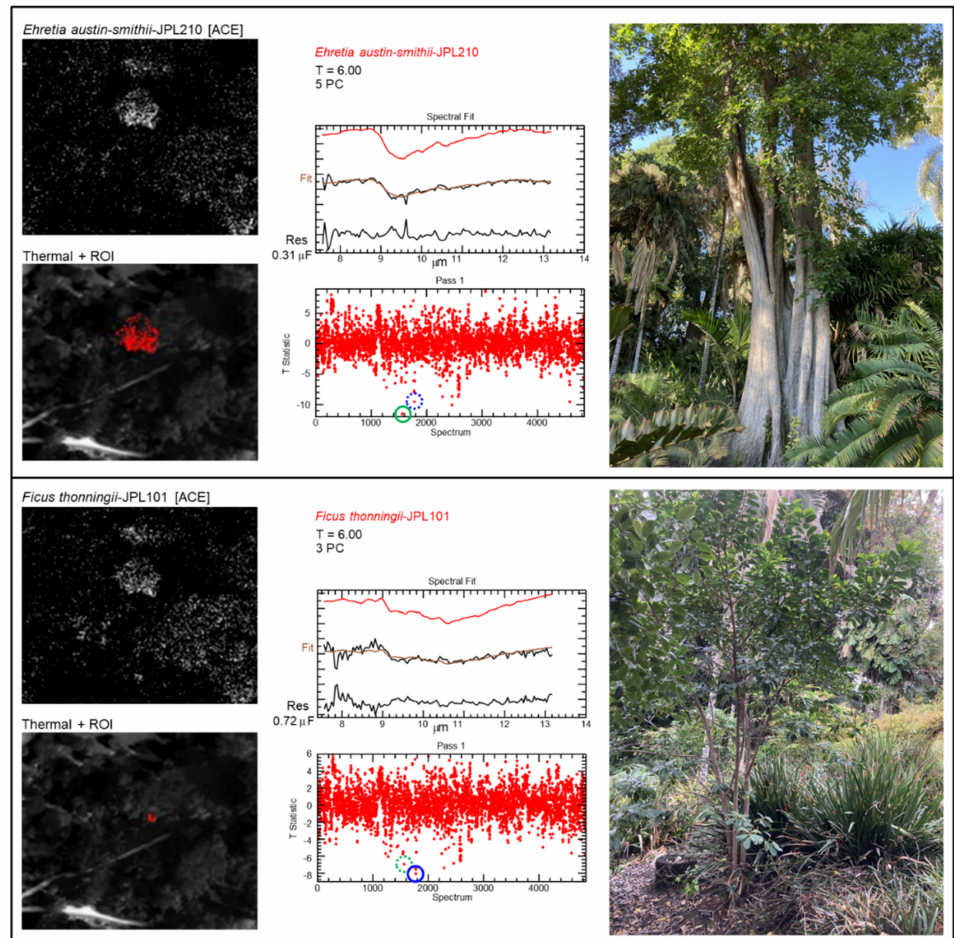
Figure 9. Spectral separation of two closely adjacent trees at the Huntington Gardens. Each specimen appears in the filter of the other and its own, but the two are accurately discriminated through their spectral characteristics. GSD: 0.5